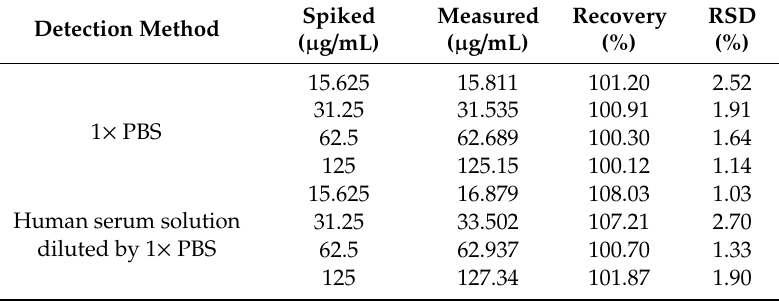
Table 3. Detection of GHSA from bu ff er and human serum